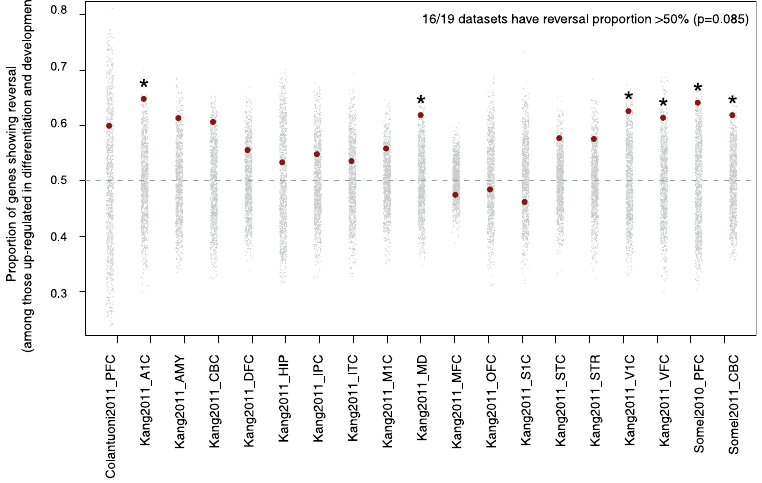
Figure 4. Reversal proportion of the genes up-regulated during in vitro neuronal differentiation and in postnatal development. The gray points show the reversal proportion in 1000 permutations of individual labels in each dataset, whereas the red points show the observed proportions ( i.e . number of up-down genes divided by the number of up-up genes, among genes up-regulated during neuronal differentiation). Statistical significance of each dataset is indicated by asterisks, which represent nominal p-values from permutations of individual ages (without correction for multiple